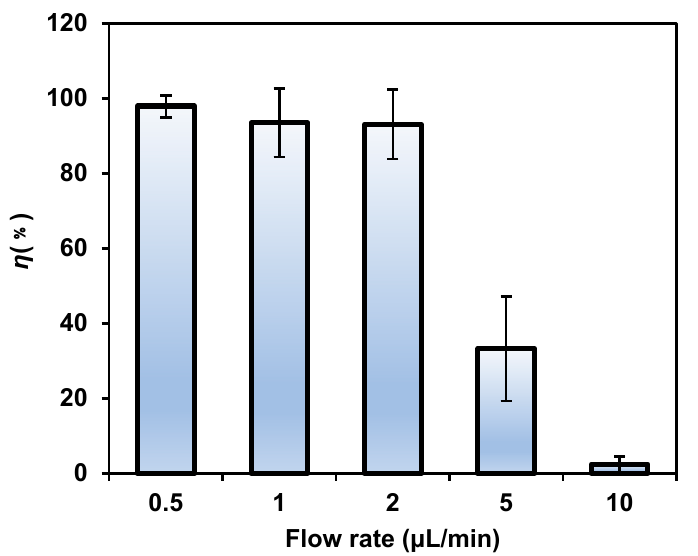
Figure 6. The lysis efficiency decreased significantly with the increase in the flow rate. The voltage was 8 V p-p and the frequency was 1 kHz.